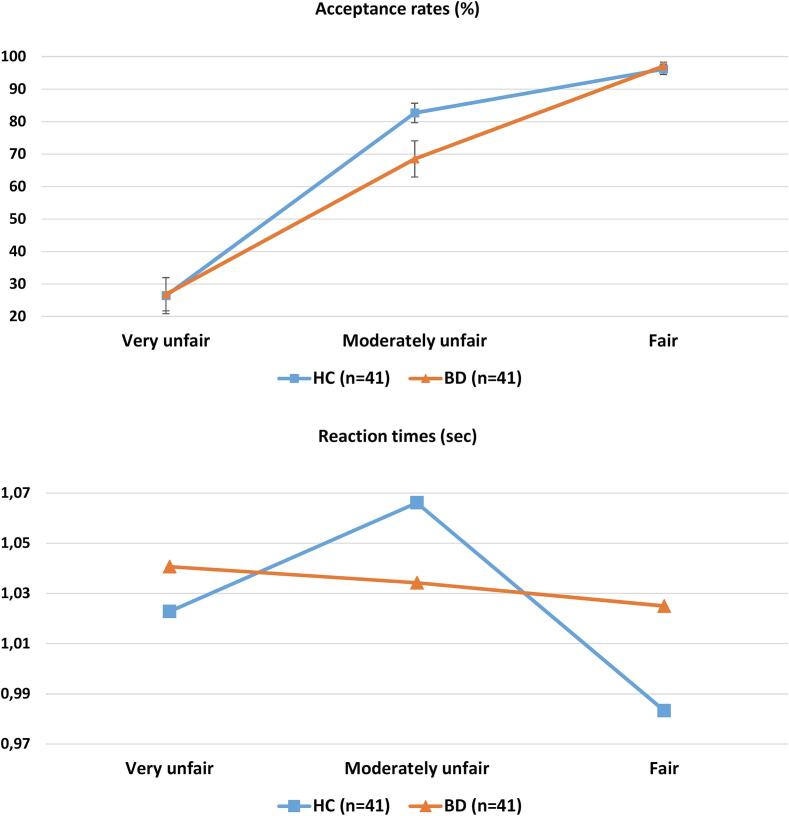
Acceptance rates and reaction times in the UG. A: Percentage of offers accepted by HC (blue) vs BD (orange) in three different levels of fairness. B: RTs (sec) of HC (blue) vs BD (orange) in three different levels of fairness. Error bars represent standard errors. (For interpretation of the references to colour in this figure legend, the reader is referred to the web version of this article.)